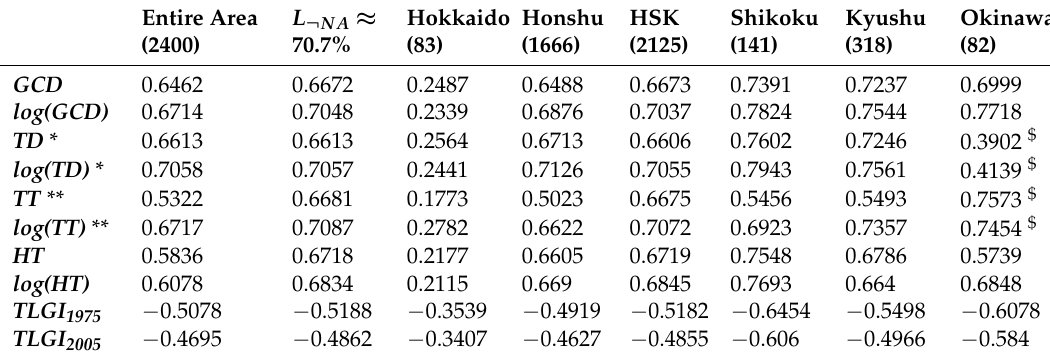
Table 1. Correlation coefficients expressed as Pearson’s r . For each set the number of localities included are given in parentheses. L ¬ NA means the survey location pairs with no missing values, i.e., where all spatial distances can be calculated. HSK stands from the set composed of Honshu, Shikoku and Kyushu. * Travel distance has a missing value proportion of 29.27% while ** Travel times have a missing value proportion of 3.14%, $ Okinawan location pairs have very few non-missing values for TD and TT